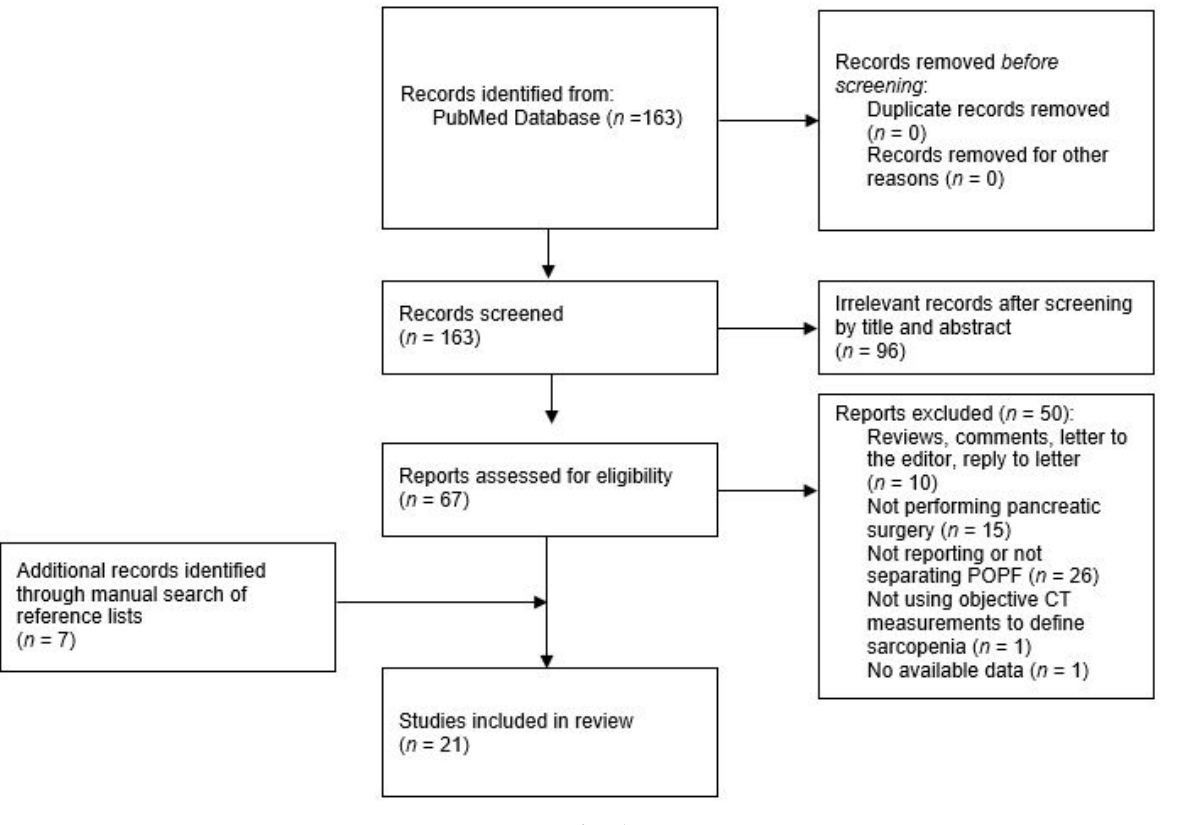
Figure 1. PRISMA flow diagram of the literature search strategy.